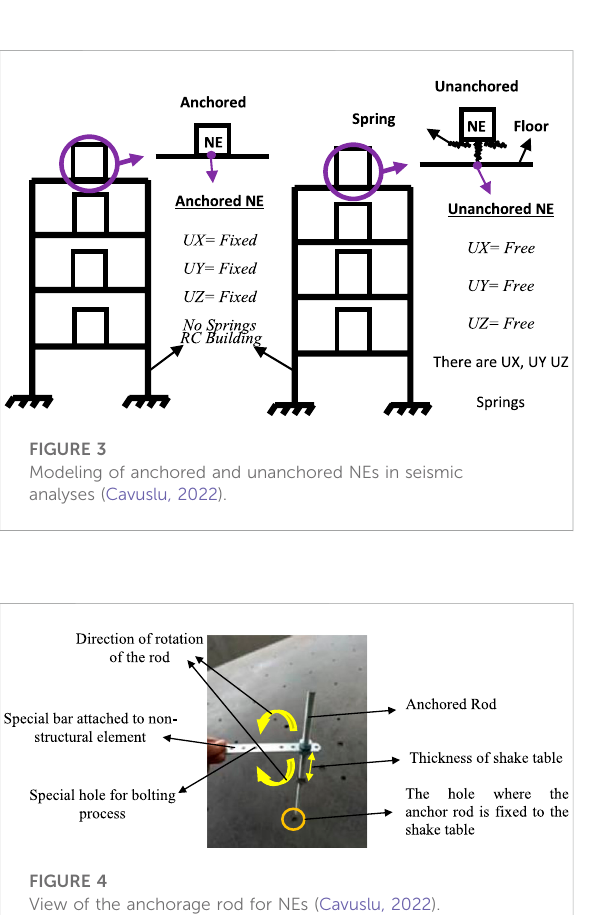
View of the anchorage rod for NEs (Cavuslu,